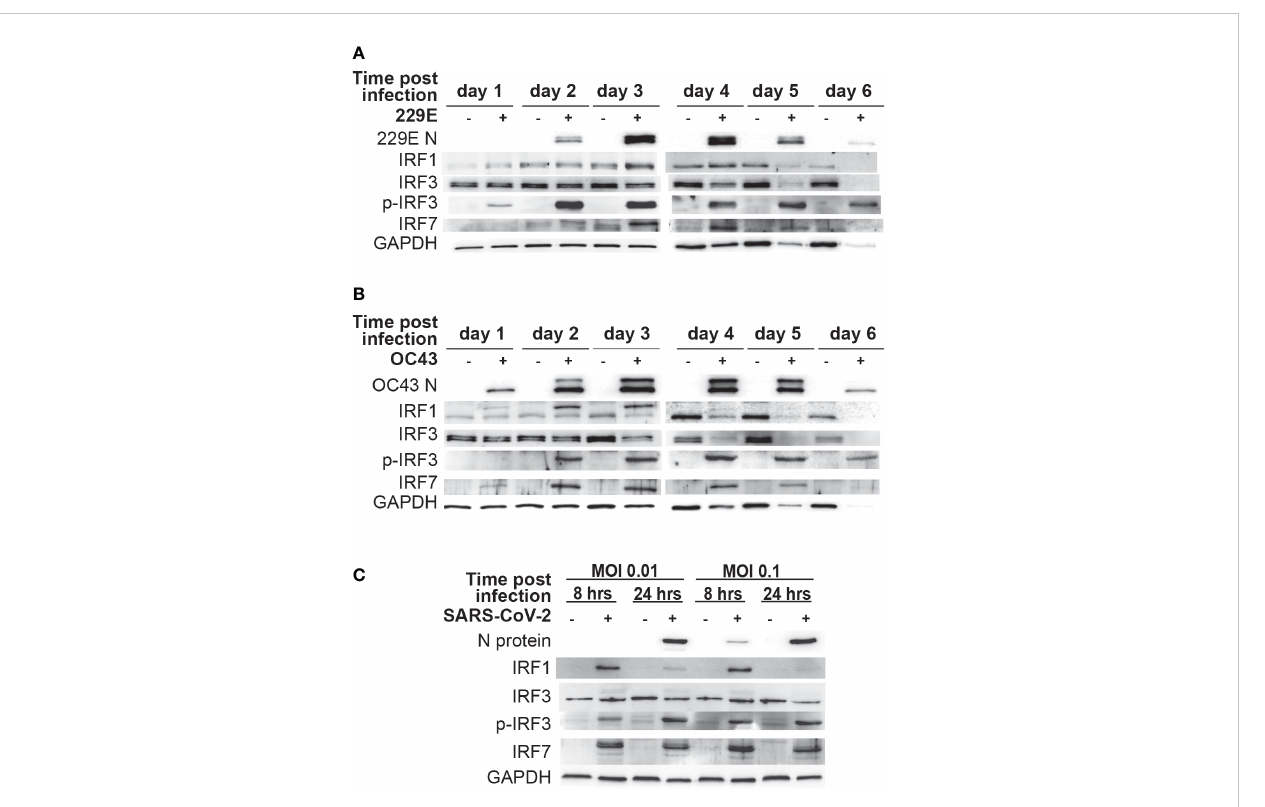
FIGURE 3 Human coronavirus infection activates IRF1, IRF3 and IRF7. MRC5 cells were left uninfected (-) or infected (+) with 229E (A) or OC43 (B) at MOI of 0.01. (C) Vero E6 cells expressing TMPRSS2 were left uninfected or infected with SARS-CoV-2 at MOI of 0.01 or at MOI 0.1. The activation of IRF1, IRF3 and IRF7 was determined by western blot analysis using antibodies against 229E N protein, OC43 N protein, SARS-CoV-2 N protein, IRF1, IRF3, IRF7, phosphorylated (p-IRF3) and